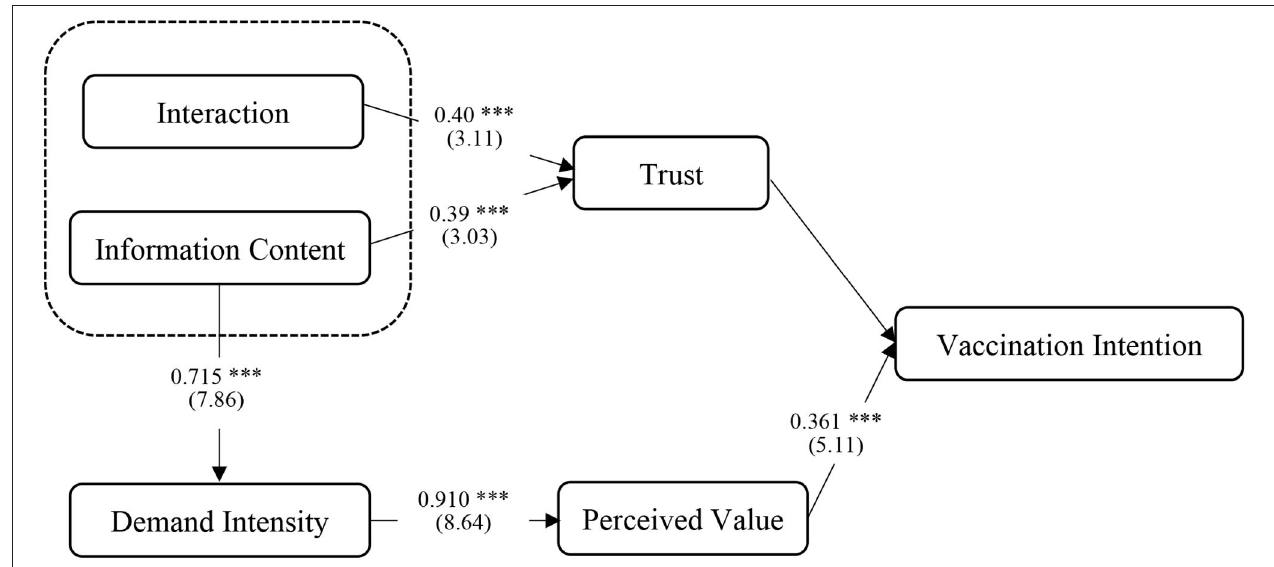
FIGURE 2 | Modified structure model. ( ) Represents t- value; *** means p <